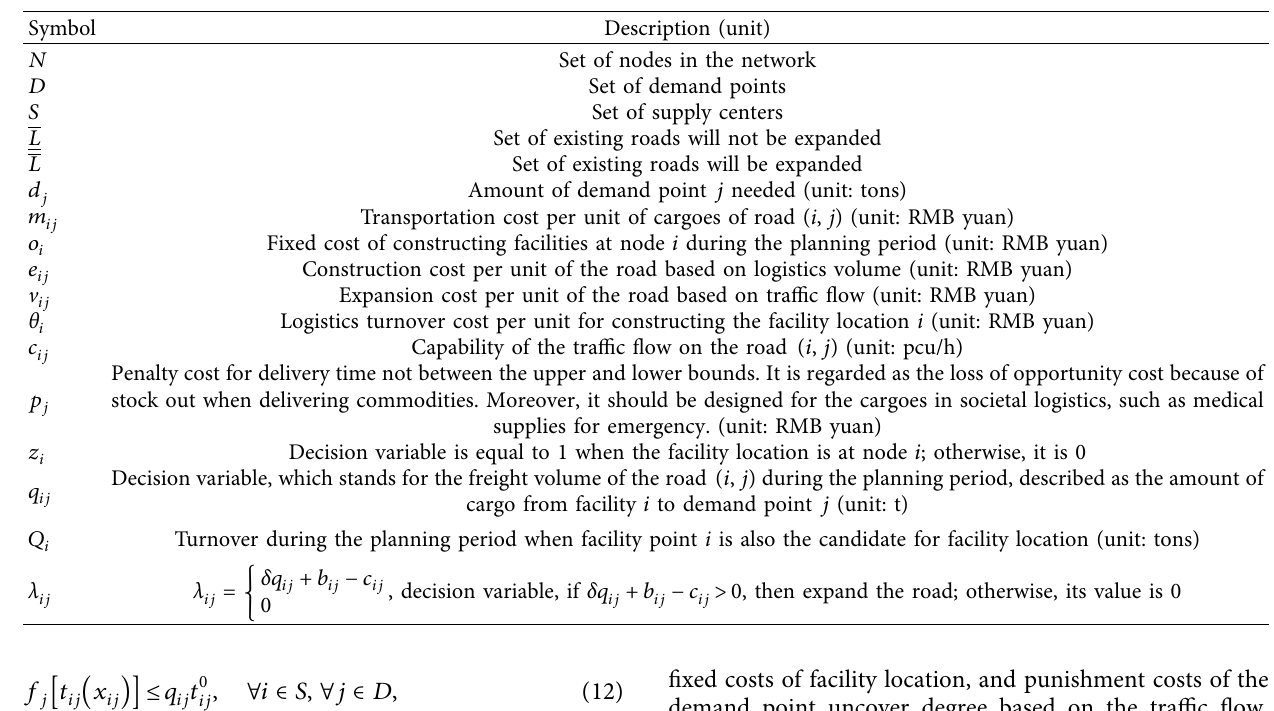
Figure 4: Uncover degree over transport time. Table 1: Symbol